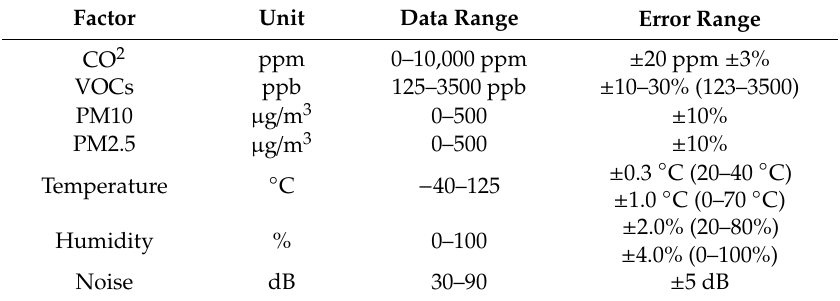
Table 2. Specifications of six sensor modules used for air quality